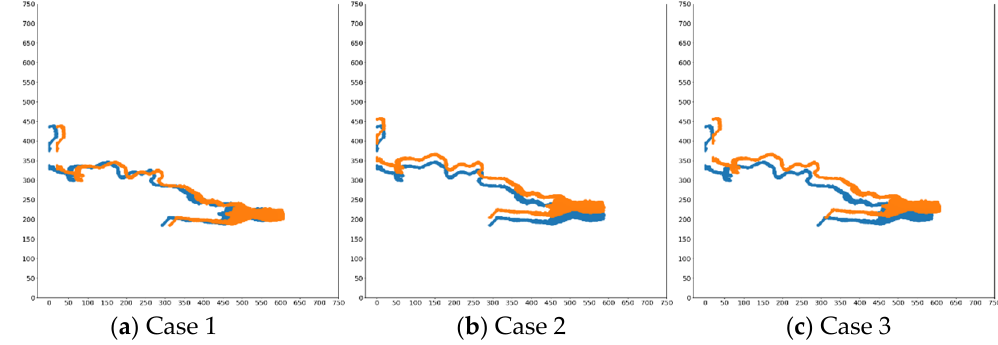
Figure 10. Unregistered cases (Case 1: x -axis; Case 2: y -axis; Case 3: both). Table 8. Similarity, Kappa and IoU results of three unregistered cases.